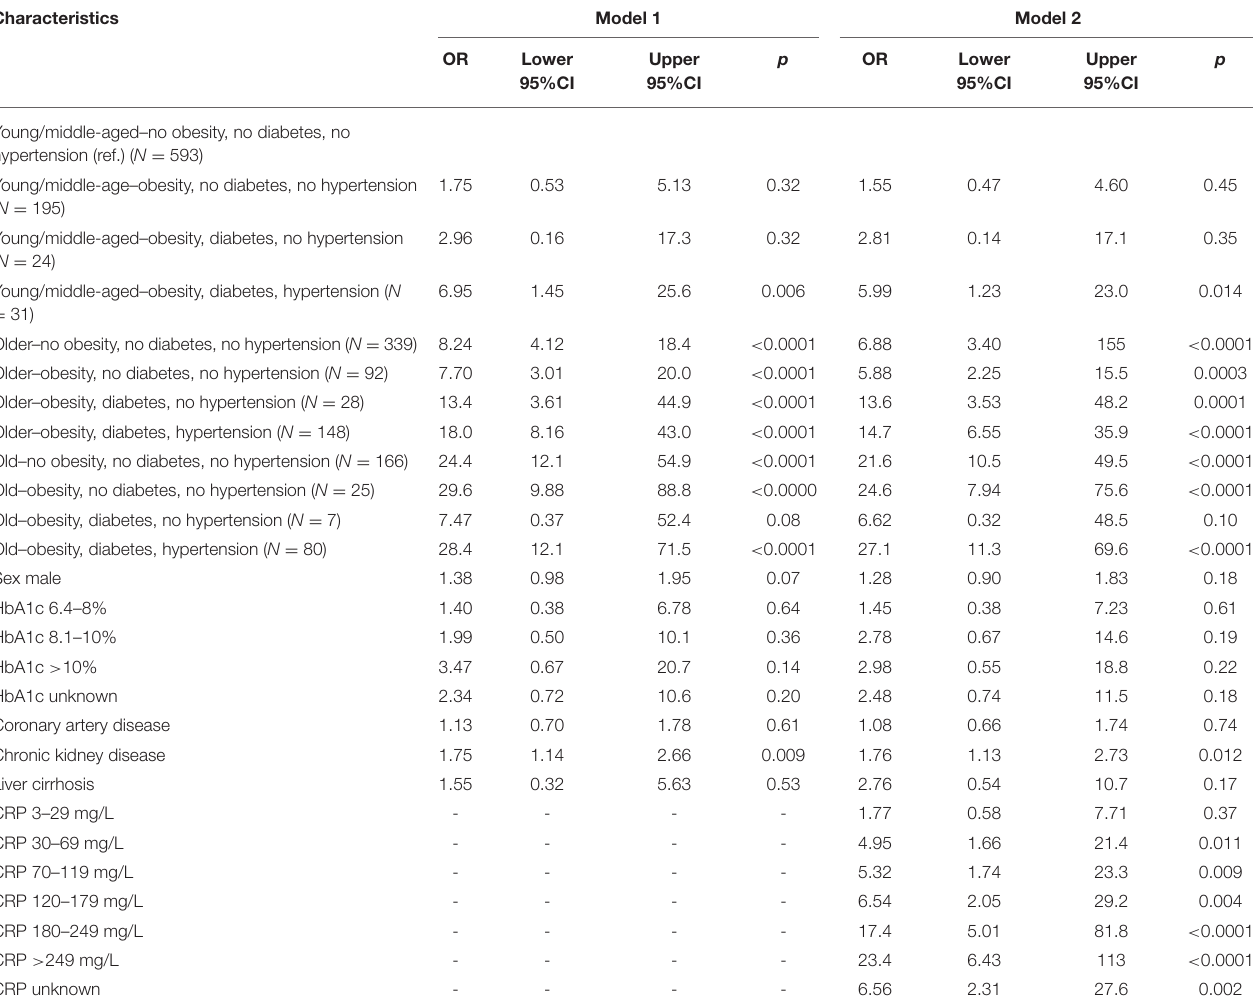
TABLE 2 | Multivariable relationships of three age groups based on the presence (unhealthy) or absence (healthy) of obesity, diabetes and hypertension and selected anthropometrics, comorbidities and laboratory parameters with COVID-19-related mortality.